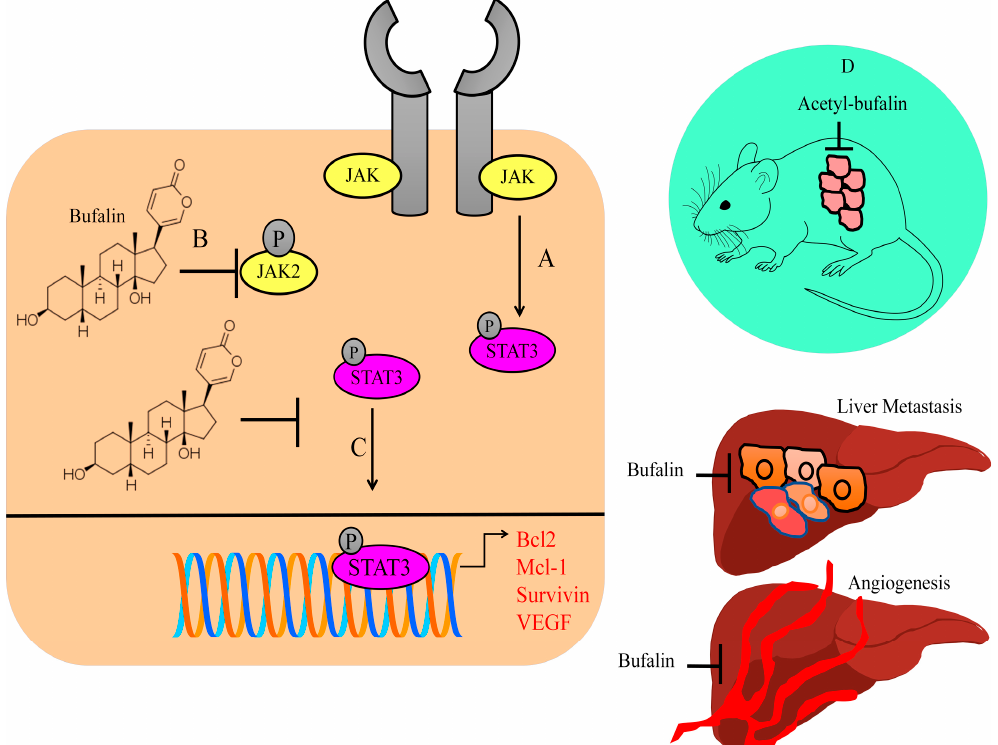
Figure 1. ( A ) JAK/STAT signaling triggered the upregulation of Bcl2, Mcl-1, survivin, and VEGF. JAK2 phosphorylated STAT3 and promoted nuclear accumulation of STAT3 proteins. ( B , C ) Bufalin inhibited the activation of JAK2 and STAT3. ( D ) Acetyl-bufalin inhibited tumor formation in mice. Bufalin also inhibited angiogenesis and liver metastasis.